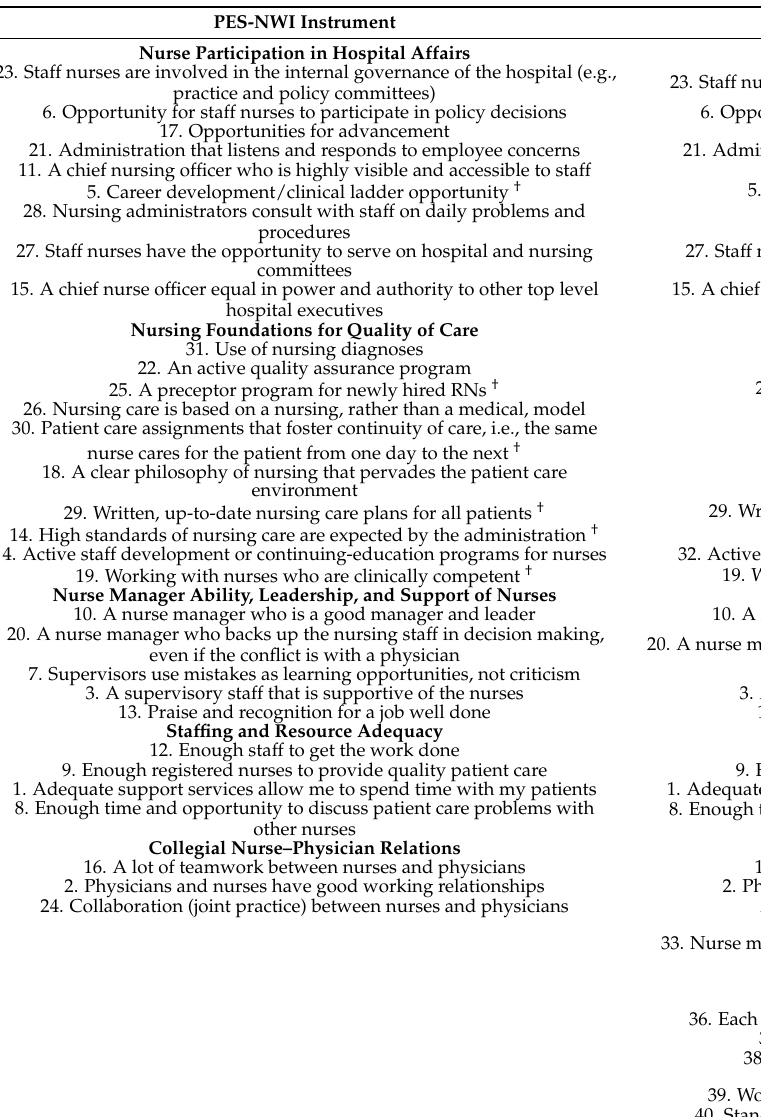
Table A1. The similar PNWE items matched to the PES-NWI